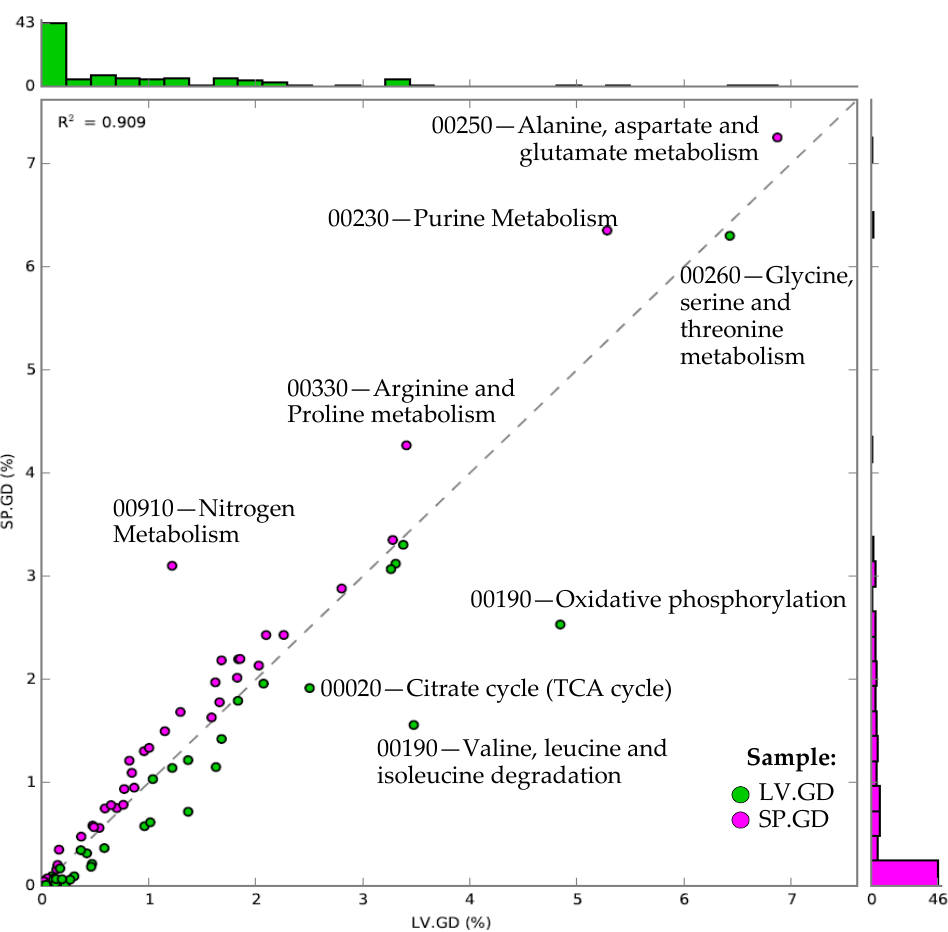
Figure 4. Relative abundance scatter plot analysis of the KEGG map Ids derived from the KEGG- Level-1 category of “metabolism”. KEGG map Id data was retrieved from the KEGG-Level-3 functional categories from MG-RAST (v4.0.3) and was uploaded into STAMP (v2.1.3). Technical replicates were grouped, and count data were normalized as the relative proportion of each KEGG map Id per group from the KEGG-Level-1 category of metabolism. The X-axis and Y-axis show each KEGG map Id relative abundance per group, including the histograms to show the number of functional entries falling at the specified abundance on the scatter plot. Those KEGG map Ids that were noticeably enriched in one group were indicated by their KEGG pathway name and Id number. The regression statistic (R 2 ) was also shown in the plot. Sample groups and color codes are indicated as LV.GD = green sea urchin Lytechinus variegatus gut digesta (green); SP.GD = purple sea urchin Strongylocentrotus purpuratus gut digesta (purple).